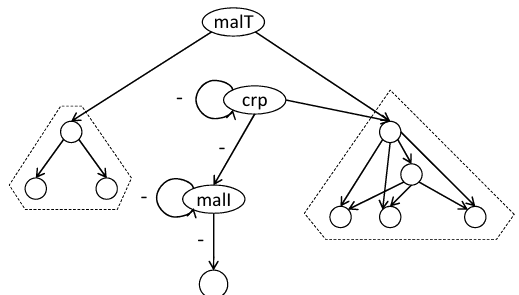
Figure 10: The network from E. coli involving the malT